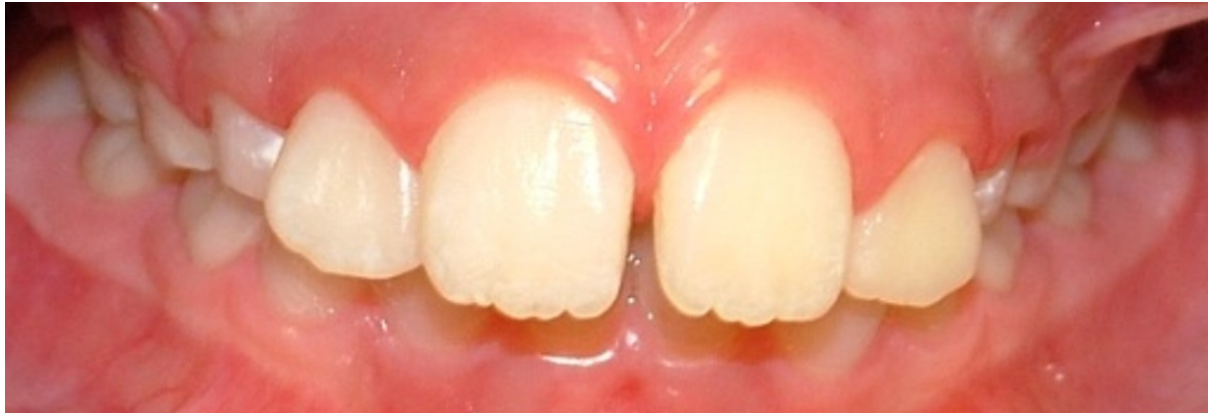
Figure 1. Deep bite in a mixed dentition patient.